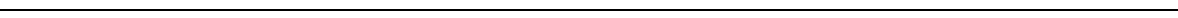
Fig. 4 Functional analyses of neo-epitope speci fi c PBLs and TILs. a Higher functional avidity of HHAT L75F -speci fi c TIL and PBL clones. Shown are the relative frequencies of IFN γ -producing CD8 + T cells (mean ± SD). b Higher functional avidity (mean ± SEM) of HHAT L75F -speci fi c TILs compared with PBL clones based on TNF α and IL-2 release (Supplementary Fig. 5 shows raw data). c Higher cytolytic capacity of HHAT L75F -speci fi c TILs compared with PBLs. Data show the percentage of lysis of T2 cells pulsed with different concentrations of the cognate neo-epitope. d Mass cytometry analysis showing the relative phosphorylation of ERK1/2 and S6 proteins involved in TCR-signaling pathways following CD3 stimulation of PBL and TIL clones. Graphs represent mean ± SEM. Supplementary Fig. 6 shows raw data. e Mass cytometry analysis showing the relative expression of different markers on neo-epitope speci fi c PBLs and TILs. Naive and memory bulk peripheral blood CD8 + T cells are shown for comparison. f Analysis of the repertoire of the T-cell receptor β (TCR β ) V-J segment recombination of HHAT L75F -speci fi c CD8 + T cells isolated from either PBLs (top) or TILs (bottom) after FACS sorting using multimers. V and J segments are represented according to chromosomal location on the x and y -axis, respectively. Arrows identify dominant TCR β sequences that were associated to TCR α sequences shown in Supplementary Fig. 8. g Calculated TCR/pMHC complexes for PBL and TIL-related TCRs: HHAT L75F -PBL- hTRAV05 + hTRAJ34/hTRBV11-2 + hTRBJ02-7 on the top, and HHAT L75F -TIL-hTRAV38-2 + hTRAJ33/hTRBV12-3 + hTRBJ02-3 at the bottom. The peptide is shown in ball and stick, colored according to the atom types. MHC ribbon is colored in brown, with residues displayed in thick lines and colored according to the atom types, with carbon colored in brown. TCR α ribbon is colored in light blue, with residues displayed in thick lines and colored according to the atom types, with carbon colored in light blue. TCR β ribbon is colored in pink, with residues displayed in thick lines and colored according to the atom types, with carbon colored in pink. Hydrogen bonds and ionic interactions are shown as thin blue lines. Dotted blue lines indicate hydrogen bonds accessible through thermal fl uctuations. Residues are labeled in brown, black, blue, and pink, for MHC, peptide, TCR α , and TCR β ,